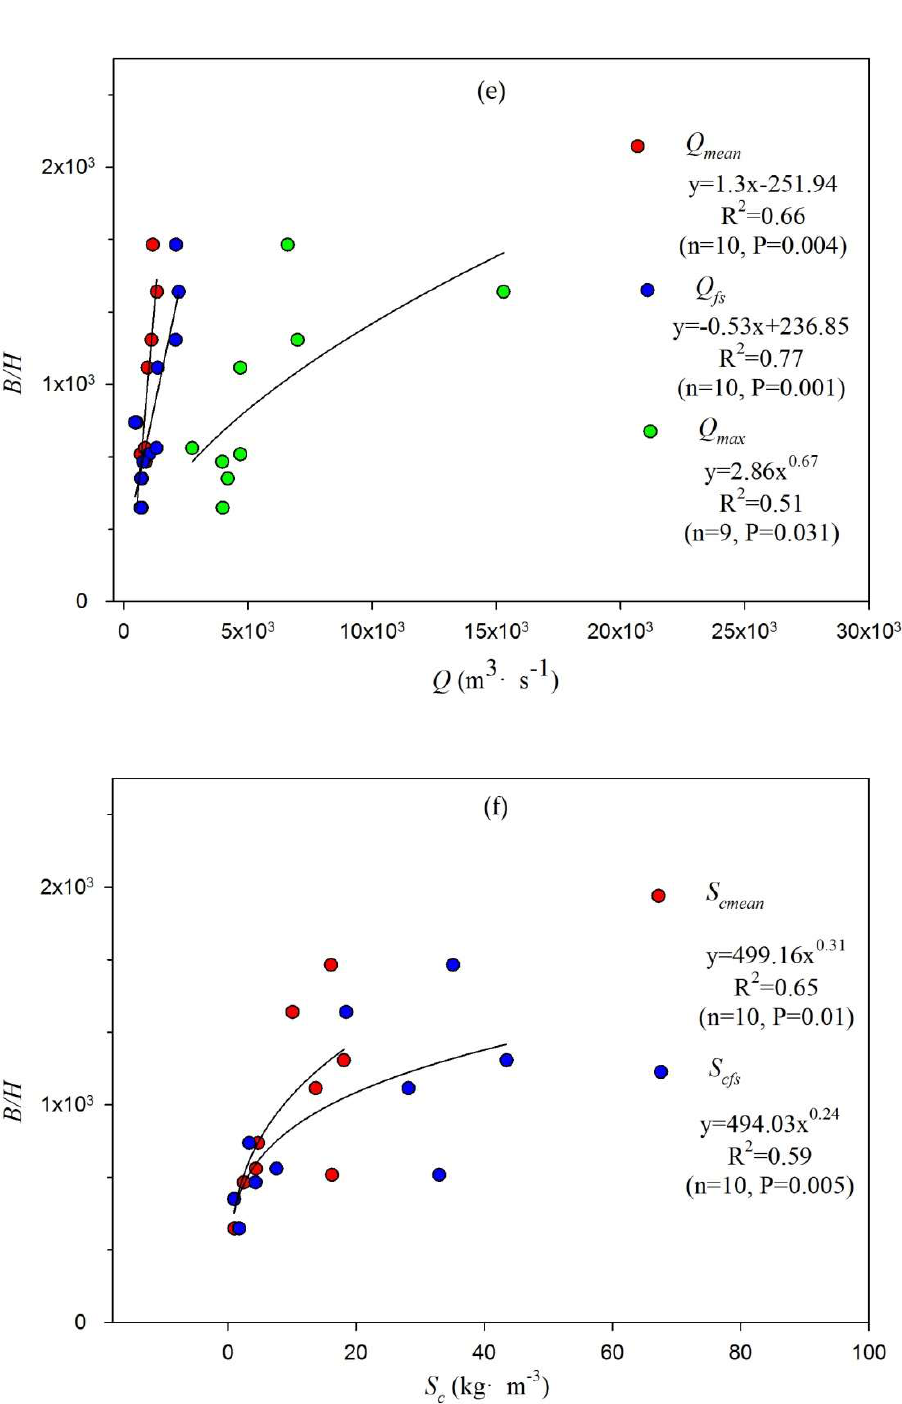
Figure 16. Relationships of the reach-scale width ( B ), depth ( H ), and width/depth ratio of the main channel ( B/H ) measured in the post-flood season, respectively, with typical flow discharge ( Q ) and sediment concentration of flow (S c ): ( a ) ( c ) and ( e ), Q mean is the annual mean flow discharge (m 3 ·s −1 ), Q fs is the annual mean flow discharge in the flood season (m 3 ·s −1 ), and Q max is the annual maximum flow discharge (m 3 ·s −1 ); and ( b ) ( d ) and ( f ), S cmean is the annual mean suspended sediment concentration of flow (kg·m −3 ) and S cfs is the annual mean suspended sediment concentration of flow during the flood season (kg·m −3 ).